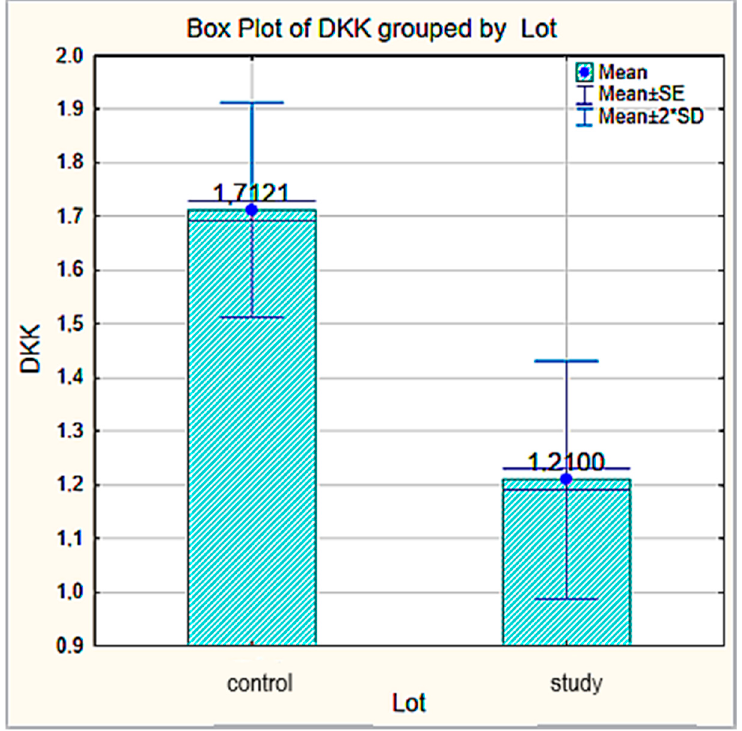
Figure 4. Dkk ‐ 1: comparative descriptive statistics in the control/test group. Figure 4. Dkk-1: comparative descriptive statistics in the control/test